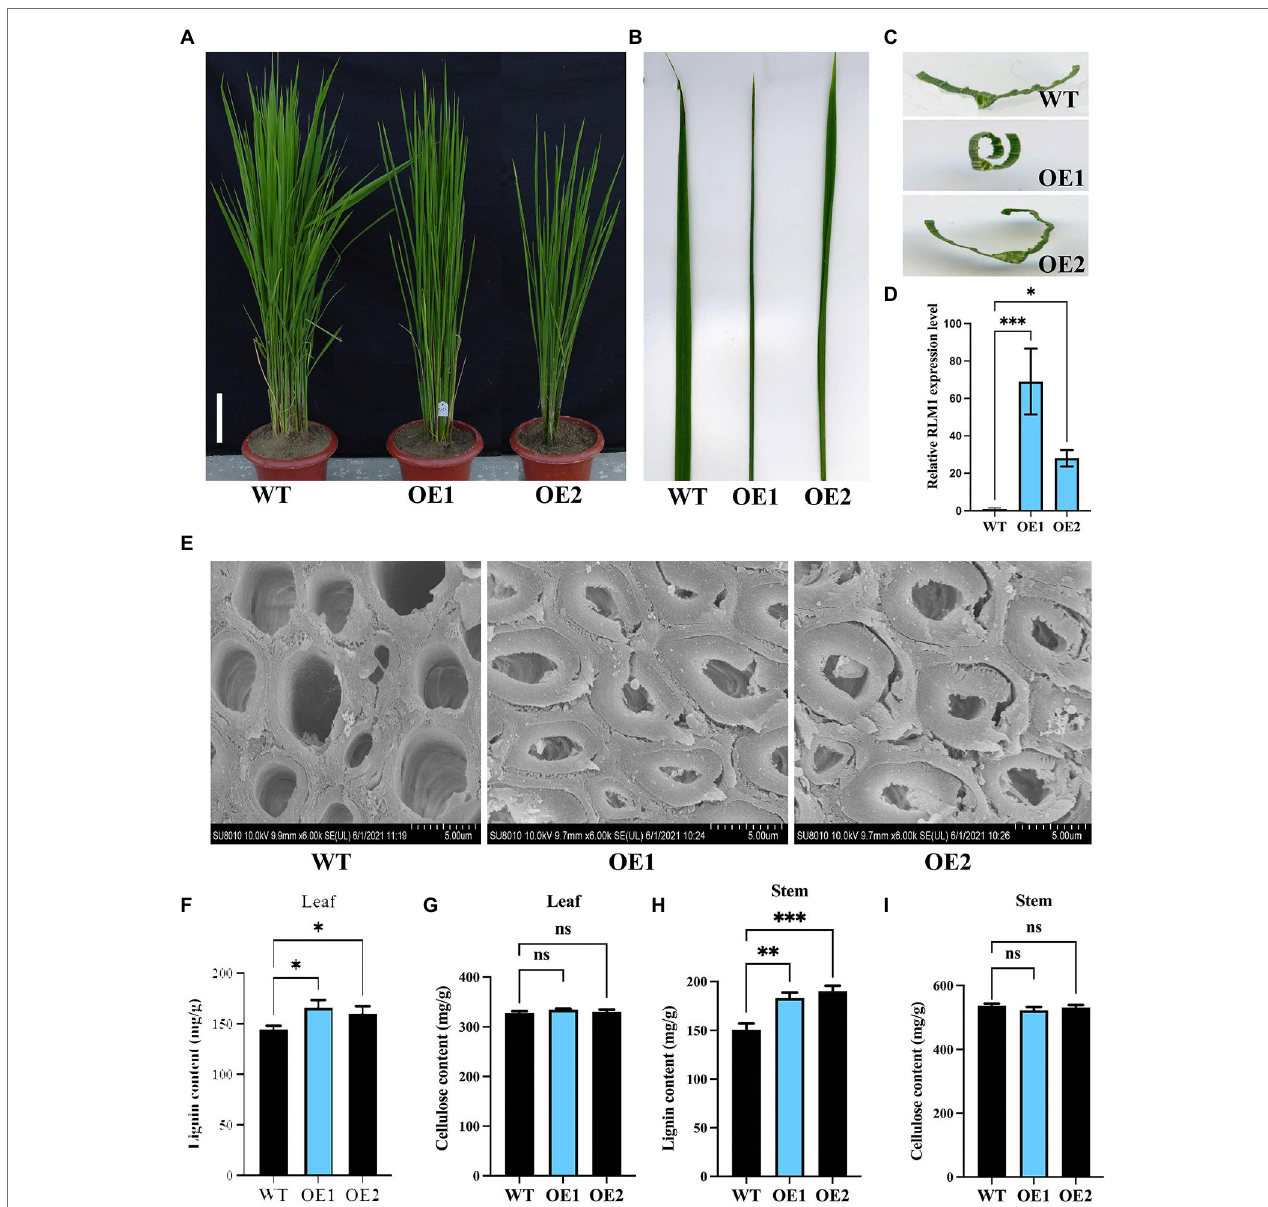
FIGURE 4 | Analysis of RLM1 overexpression in the WT background. (A) Comparison of WT and RLM1 overexpression plants (OE1, OE2) at the late-tiller stage. Bar = 5 cm. (B) Flag leaf comparisons of the plants shown in (A) . (C) Flag leaf cross-section comparisons of the plants shown in (A) . (D) . RLM1 expression level analysis of WT and RLM1-overexpressing plants (OE1, OE2). (E) SEM observations of sclerenchyma cell walls in the internodes from the 3-month-old WT, OE1, and OE2 plants. Bar = 5 μ m. (F) Lignin content measurements in WT, OE1, and OE2 leaf tissues. (G) Cellulose content measurements in WT, OE1, and OE2 leaf